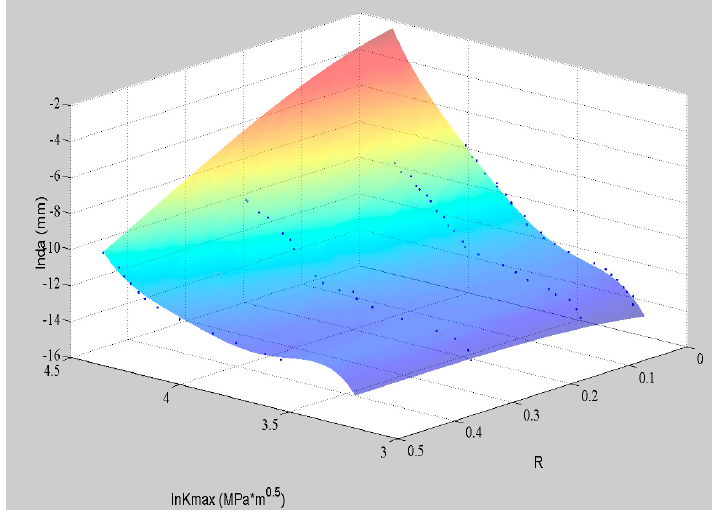
Figure 10. The experimental data of Al2024-T315 and the corresponding ANN.